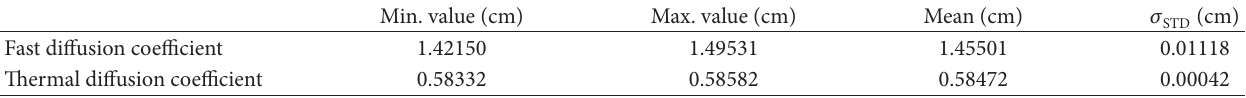
T 7: Uncertainty analysis of fast and thermal diffusion coefficients (JENDL-4).